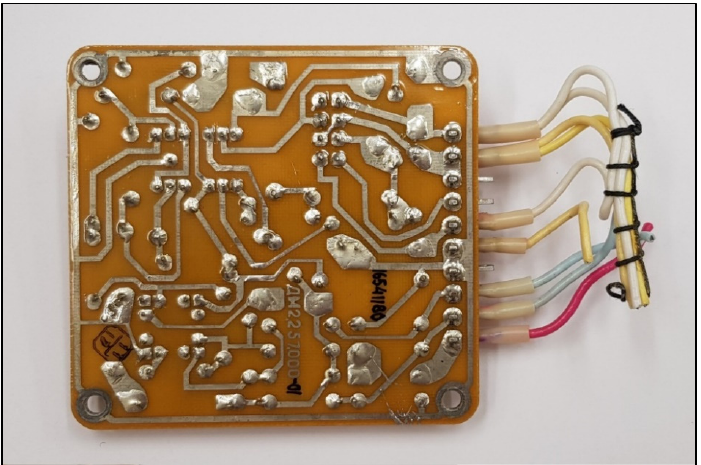
Figure 5. PCB of the BI-2A block of amplifiers from the side of the connections of the electronic